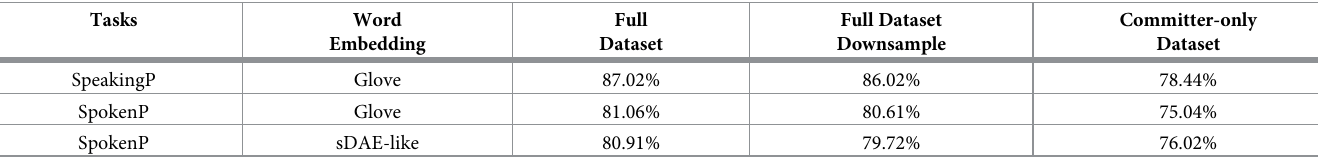
Table 1. AUCs of our language